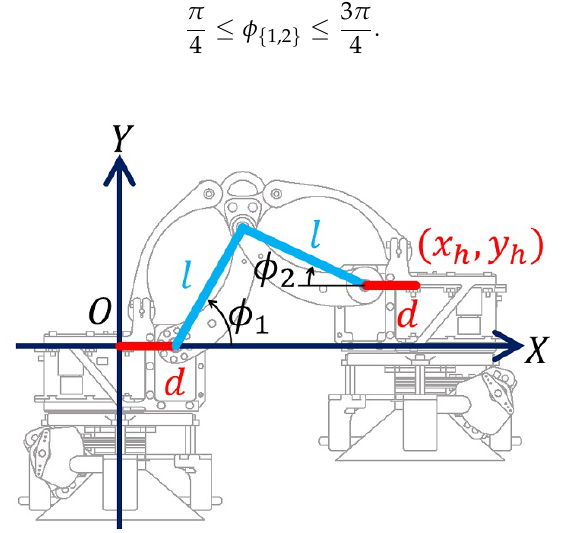
Figure 4. A schematic figure of a vertical plane of the arm of the designed